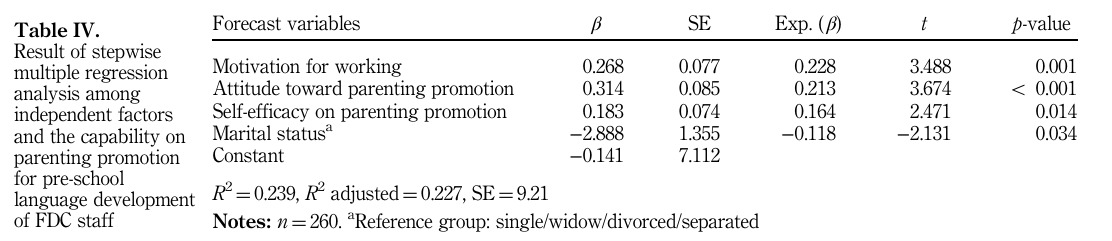
Table IV. Result of stepwise multiple regression analysis among independent factors and the capability on parenting promotion for pre-school language development of FDC